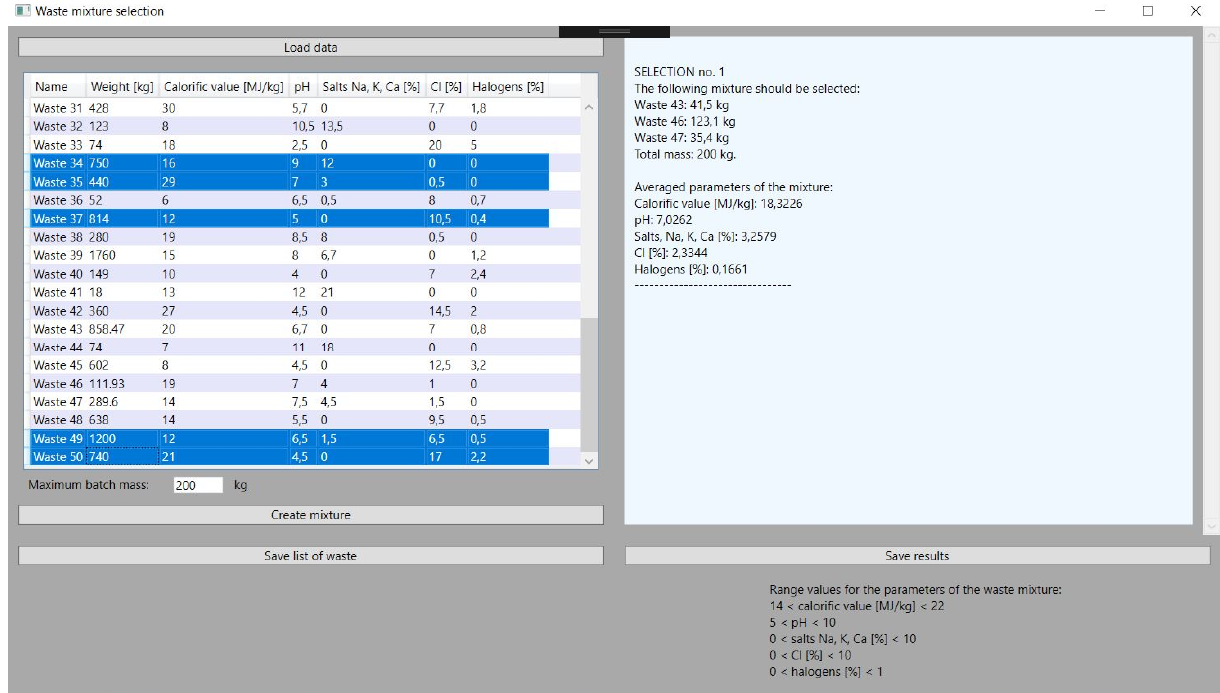
Figure 7. Selection of the next mixture from other types of waste.